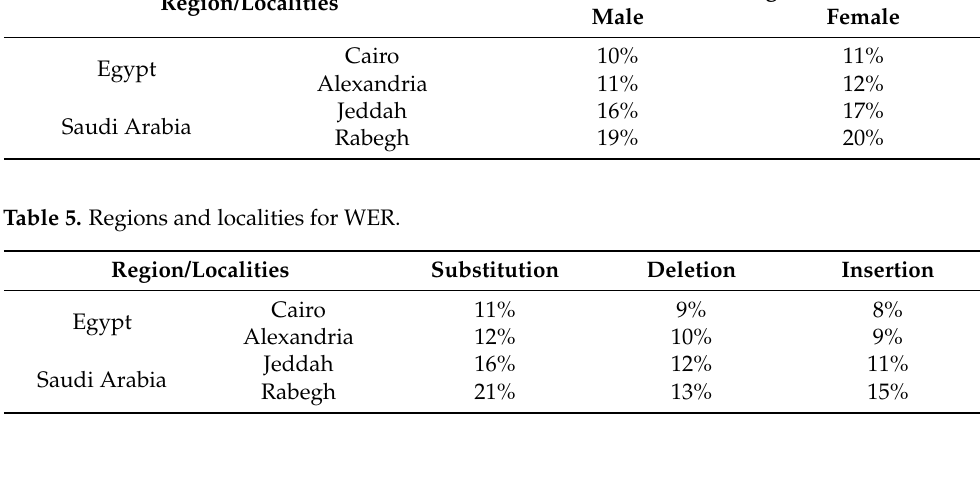
Table 4. Word Error Rate (WER) relative to different localities. Region/Localities